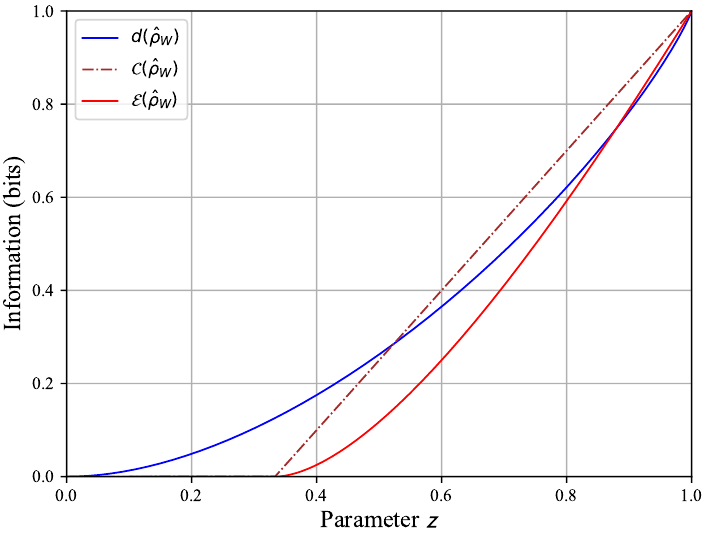
Figure 2. The entanglement rate and of the quantum discord as functions of the parameter z ∈ [ 0, 1 ] (cid:12) (cid:11)(cid:10) Ψ − (cid:12) + ( 1 − z ) / 4 ˆ I for a Werner state ˆ ρ w = z (cid:12) Ψ − (cid:12) AS . The entanglement rate E AS and the concurrence C ( ˆ ρ w ) is red. The quantum discord d ( ˆ ρ w ) in blue represents the number of quantum